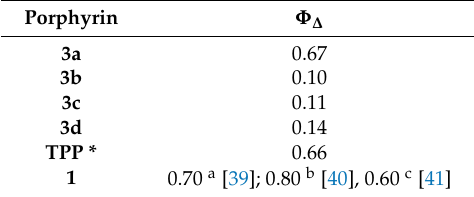
Figure 3. First-order kinetic graphical profile of photodegradation of 1,3-diphenylisobenzofuran (DPBF) by irradiation with LED array system ( λ = 635 nm) in the presence of thioaryl-porphyrin 3a . Table 3. Singlet oxygen quantum yields of thioaryl-porphyrins 3a–d .